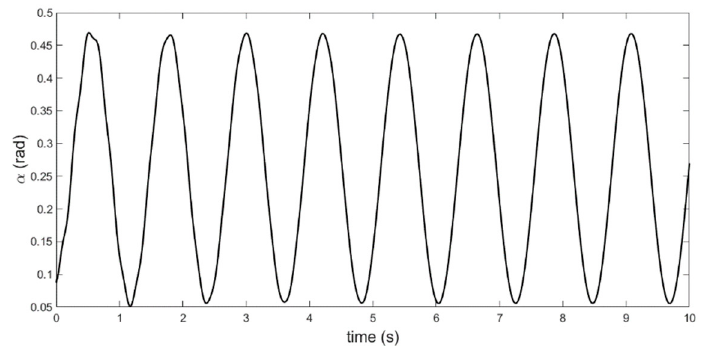
Figure 8. Time response of alpha in flutter speed (23.9 m/s).